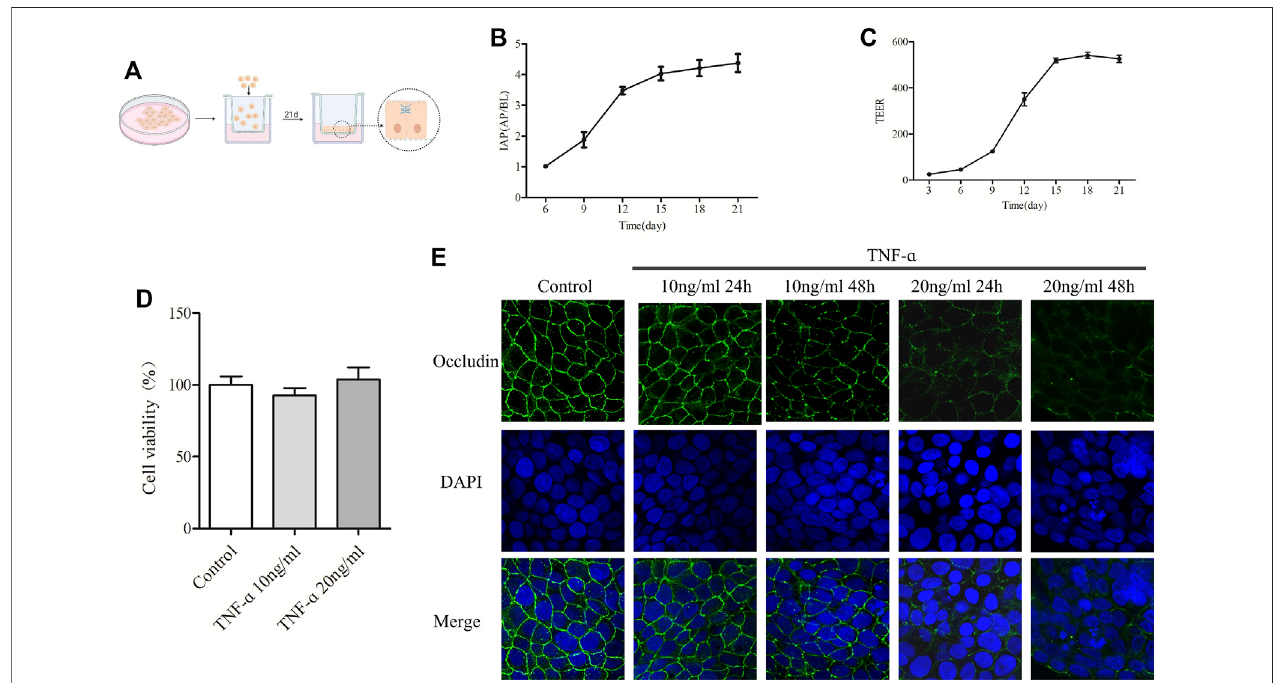
FIGURE 5 | The increased concentration of TNF- α resulted in the decrease of Occludin in Caco-2 cell monolayers. (A) Schematic diagram of culturing Caco-2 cell monolayers in the Transwell. (B) IAP activity ratio of AP and BP in different days of culture was detected. (C) TEER value of Caco-2 cell monolayers was detected on different days. (D) MTT was used todetect the effectof TNF- α at 10 ng/ml or 20 ng/ml on caco-2 cell viability. (E) Caco-2 cell monolayers were treated with 10 ng/ml or 20 ng/ml TNF- α for 24 or 48 h, and the expression of Occludin was detected by IF, n = 3 –